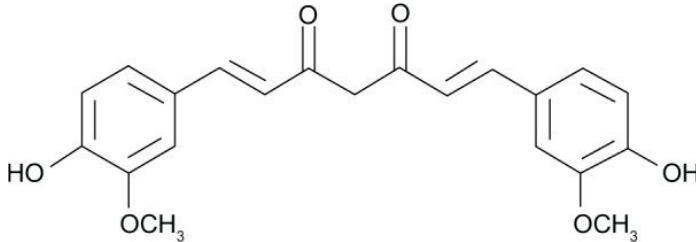
Figure 2. Chemical structure of curcumin.